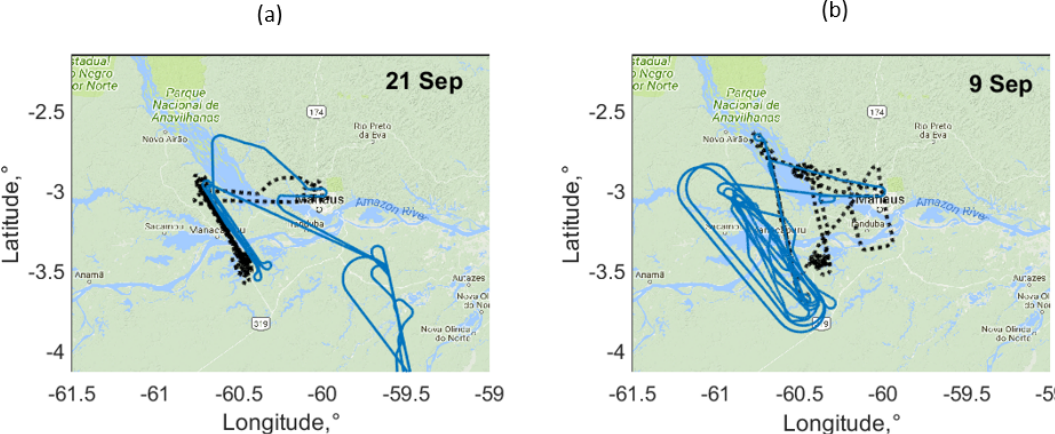
Figure 1. Coordinated flight tracks for 21 September (a) and 9 September (b) . The dotted black line is the flight track of the G1, and the blue line is the flight track of HALO. (This figure was created using Mapping Toolbox™ © COPYRIGHT 1997–2019 by The MathWorks,